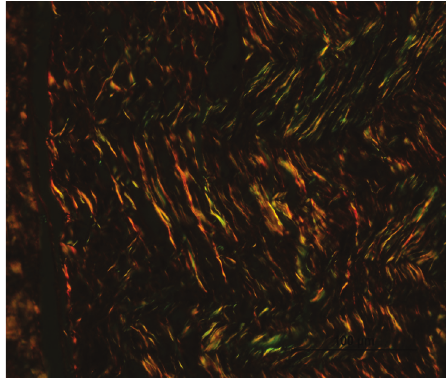
FIGURE 6 - Photomicrography in PSR staining in polarized light. Note: Longitudinal section of the cervical sympathetic nerve with 40x